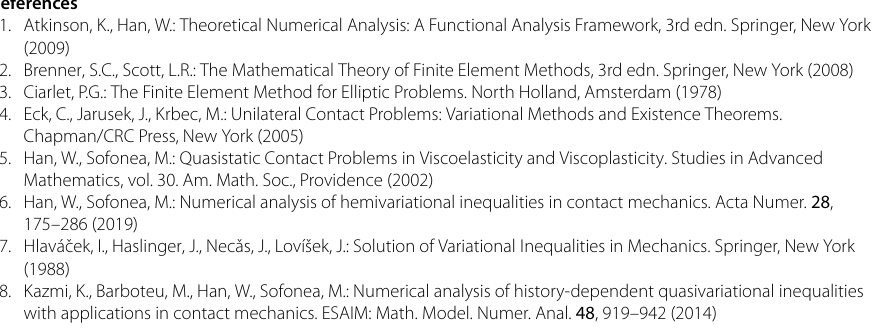
The configuration of the deformable body (cid:2) with h = k = 1 Fig. 3. The numerical solution with h = k = 1 the convergence orders in H 1 norm are reported in Table 1, Table 2, and Table 3 which illustrate the performance of the fully discrete